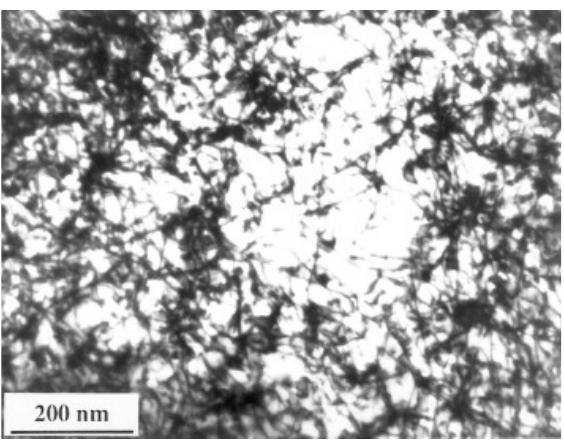
Figure 3. TEM micrograph indicates an increase in the density of dislocations during LSP of carbon steel [76].